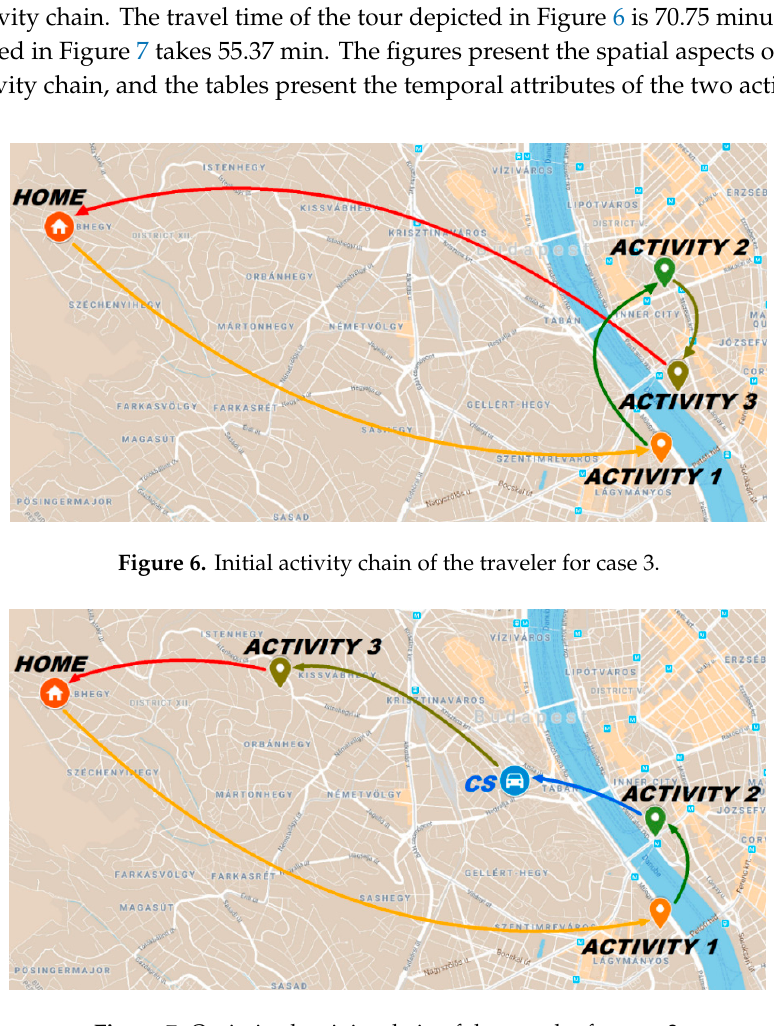
Figure 7. Optimized activity chain of the traveler for case 3. Table 7. Part of the input of the traveler regarding the spatial and temporal aspect of activities.